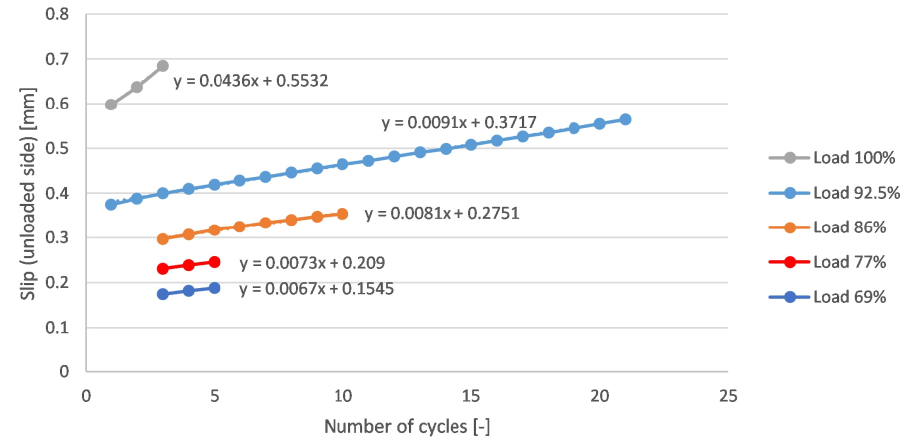
Figure 17. Slips belonging to the given cycles in case of LWAC.